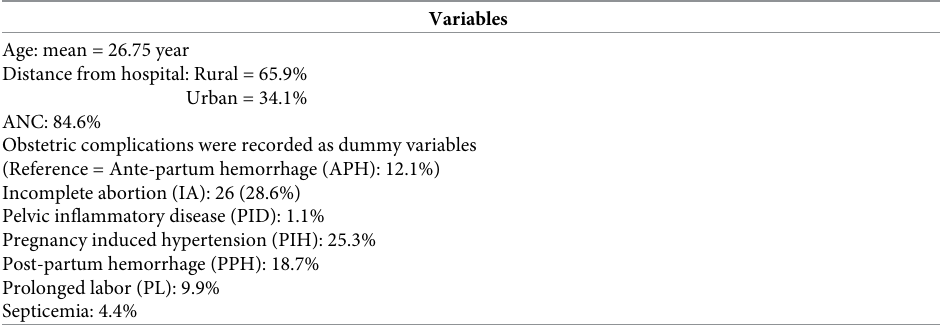
Table 4. Description of potential predictor variables (n =